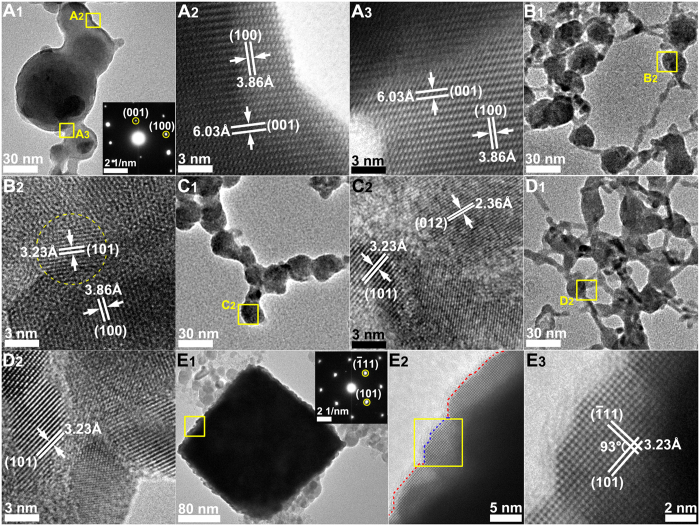
TEM images, HRTEM images, and related SAED patterns of Te agglomerates formed in various solvents.H2O (A1–A3), CH3OH (B1,B2), CH3CH2OH (C1,C2), CH3COCH3 (D1,D2) and CH2Cl2 (E1–E3).